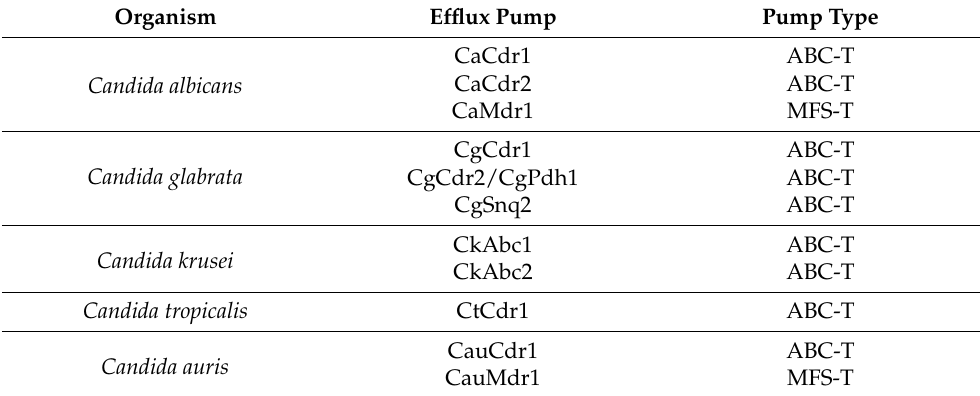
Table 2. Major multidrug transporters associated with azole